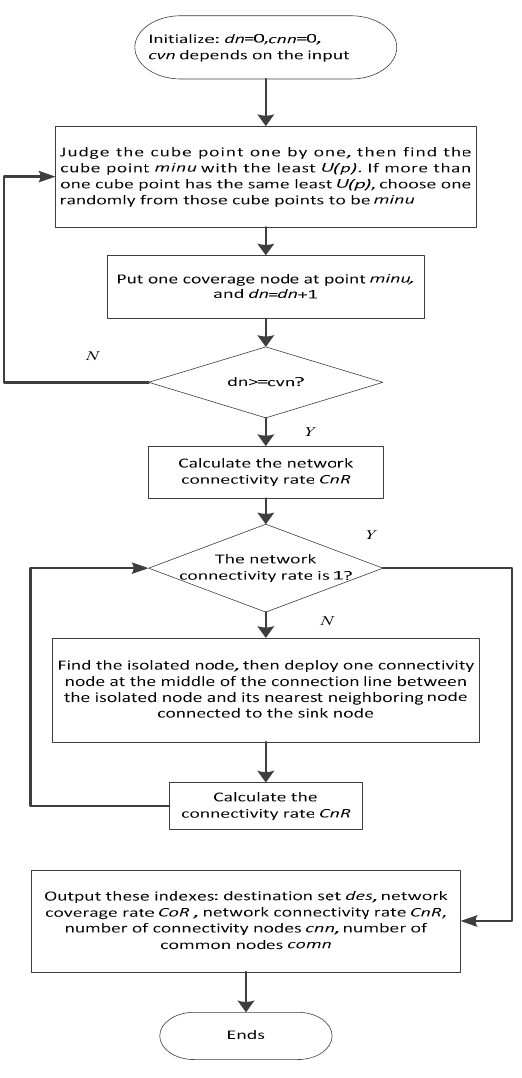
Figure 3. Flow chart of GFCND algorithm.